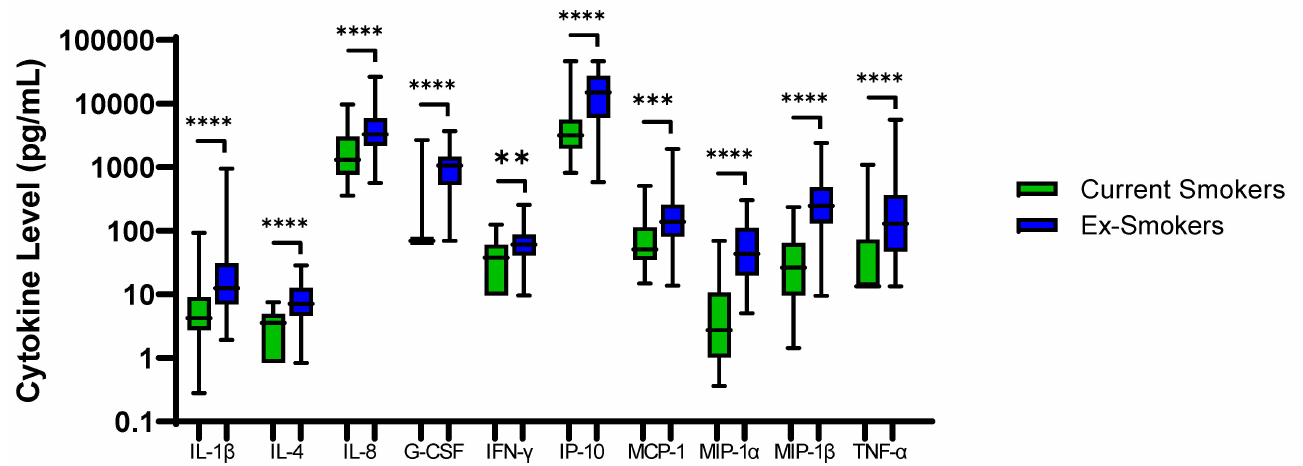
Figure 3. Sputum Biomarkers in COPD Ex-Smokers and COPD Current Smokers : Data is pre- sented as minimum, maximum and median concentrations, data analysed using Mann Whitney test.